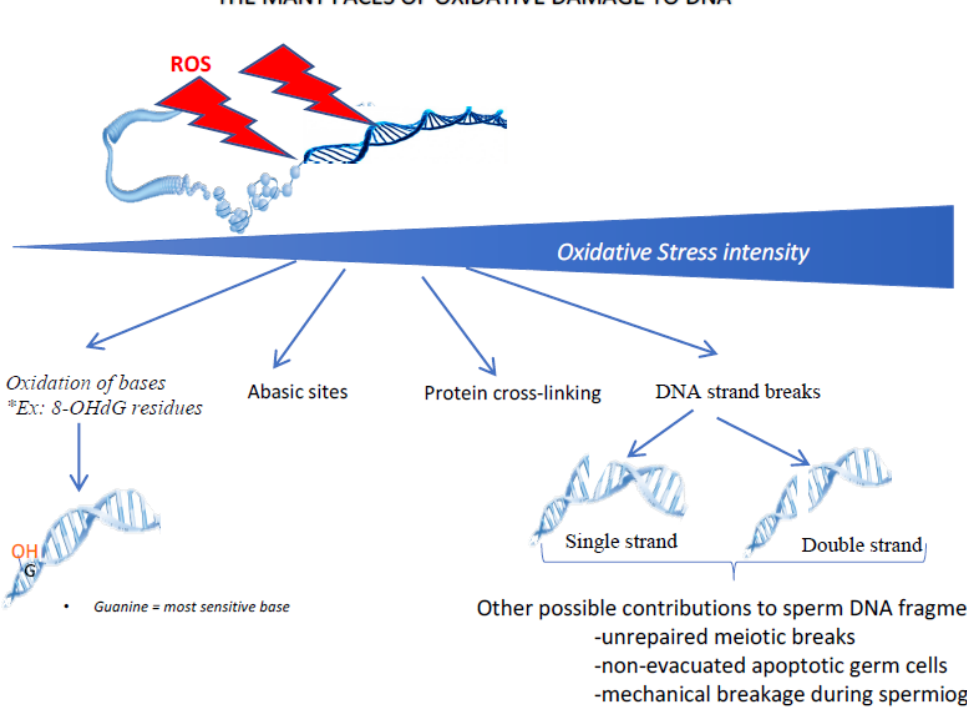
Figure 4. The oxidative damage of DNA has many faces. Depending on the intensity of oxidative stress, di ff erent types of nuclear / DNA alterations can be observed. In the case of low / light oxidative stress, the first type of damage concerns the oxidation of DNA bases (in particular guanosine and adenosine) leading to oxidized residues (such as 8-oxo-guanosine, the so-called 8-OHdG residue). When the level of oxidative stress increases, other alterations can occur, including the generation of abasic sites, cross-link of nuclear proteins and rupture of DNA strands, either single or double. Although DNA strand breaks may have an oxidative origin, it should be kept in mind that the fragmentation of sperm DNA may have other origins, including unrepaired meiotic breaks, non-processed apoptotic germ cells or mechanical shearing during late spermatogenesis (spermiogenesis) when protamines replace sperm nuclear histones.